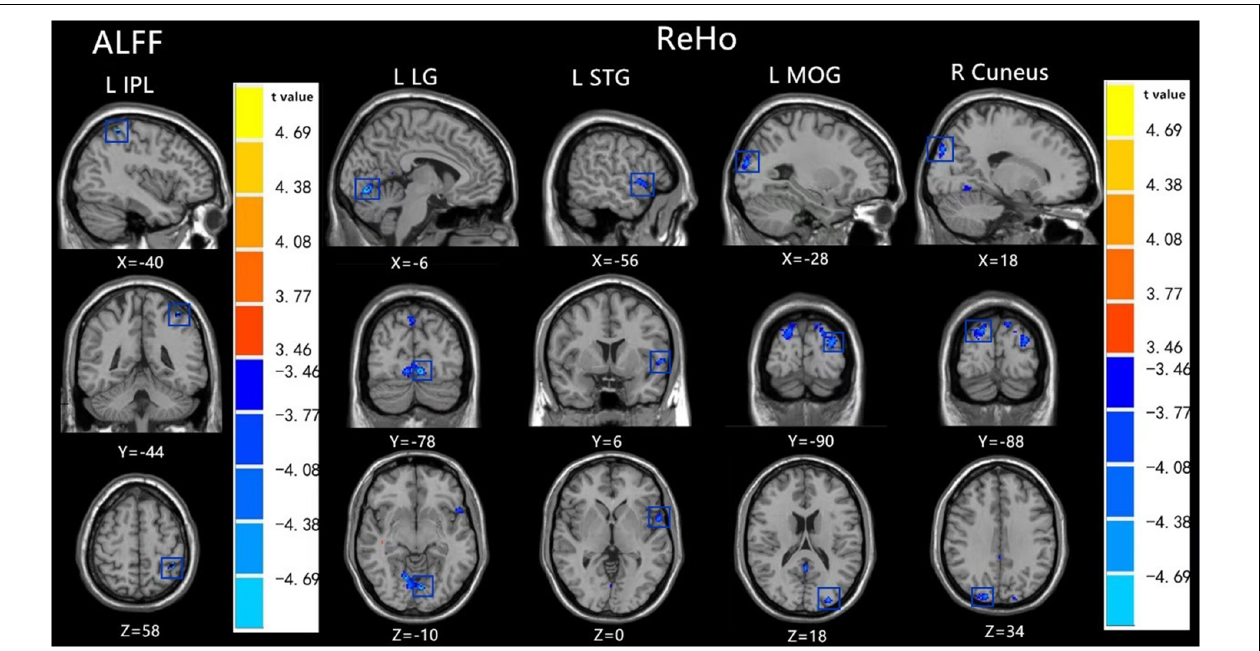
FIGURE 1 | Brain regions with abnormal ALFF (left) and ReHo (right) between the ASD group and the TD group based on t tests. Blue colors denote decreased ALFF value in L IPL and decreased ReHo values in L LG, L STG, L MOG, and R Cuneus. The blue transparent box shows the corresponding brain region. The color bars indicate the t value (FDR correction, p < 0.05). L IPL: left inferior parietal lobule, L LG: left lingual gyrus, L STG: left superior temporal gyrus, L MOG:left middle occipital gyrus. X,Y,Z is coordinates of primary peak locations of the abnormal brain region in the Montreal Neurological Institute(MNI)